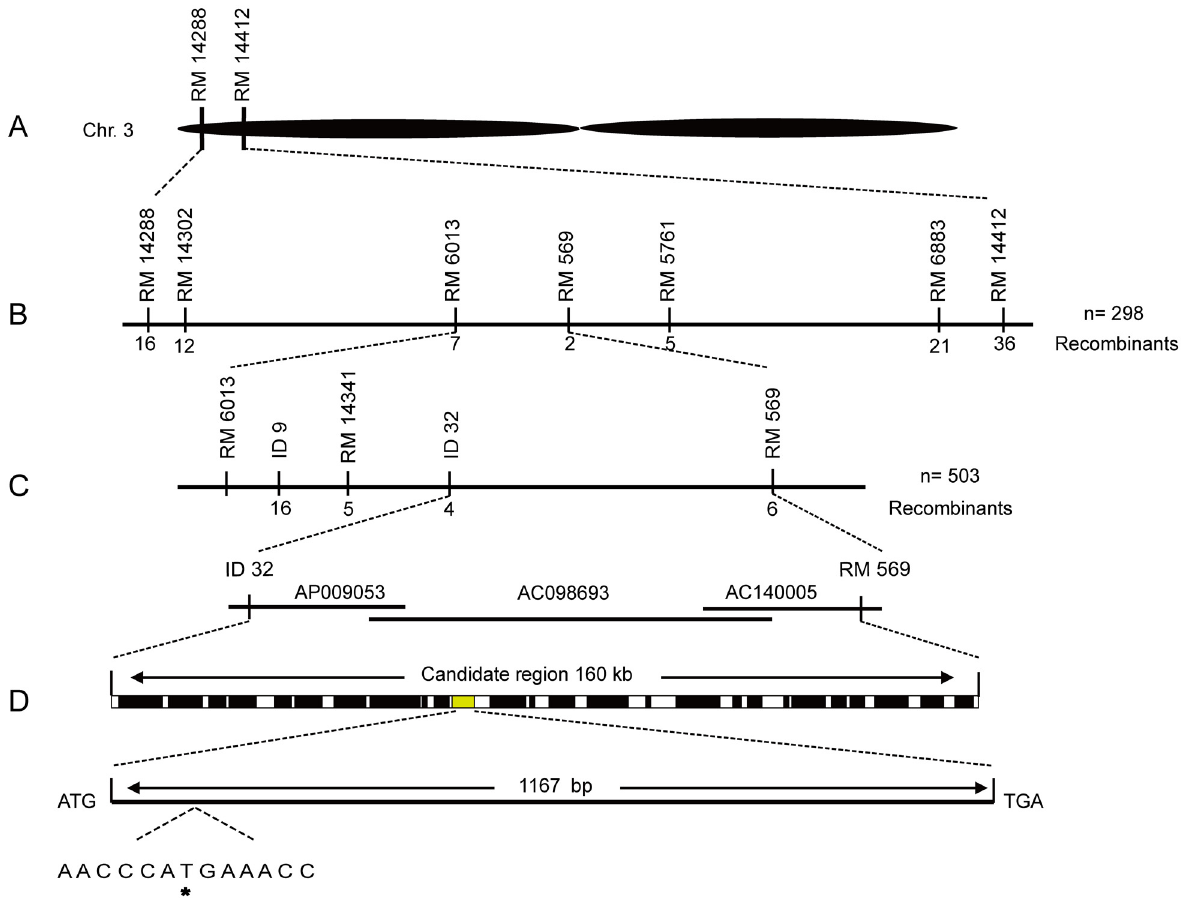
Fig 3. Map-based cloning of w67 . A, The w67 locus was mapped to short arm of chromosome 3 between SSR markers RM14288 and RM14412; B, The w67 locus was narrowed down to about 274-kb region between RM6013 and RM569 using 298 F 2 mutant individuals from cross of w67/R9308; C, The w67 locus was further mapped to about 160-kb region covering three BAC clone AP009053, AC098693 and AC140005 between InDel maker ID32 and RM569 using 503 F2 mutant type plants from cross of w67/Moroberekan; D, 26 ORFs were predicted in the mapped region and a single nucleotide substitution from A to T at position 130 in LOC_Os03g03990 was identified. Markers used for mapping are listed in S2